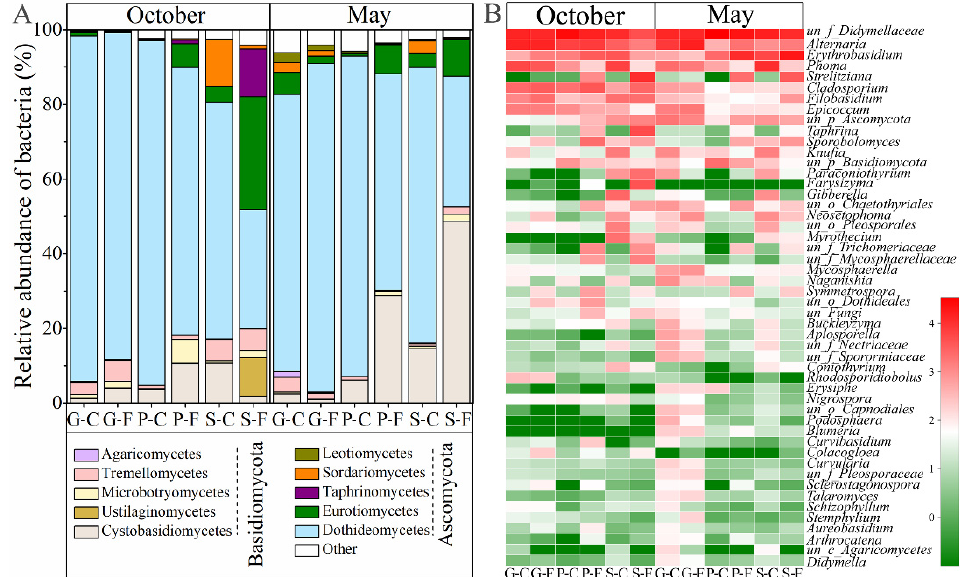
Figure 2. The relative abundance of leaf-associated fungi at class ( A ) and genus ( B ) level of three types of plants from two locations over two seasons. un, unclassified; G-C, G. biloba from campus; G-F, G. biloba from the forest; P-C, P. bungeana from campus; P-F, P. bungeana from the forest; S-C, S. chinensis from campus; S-F, S. chinensis from the forest.